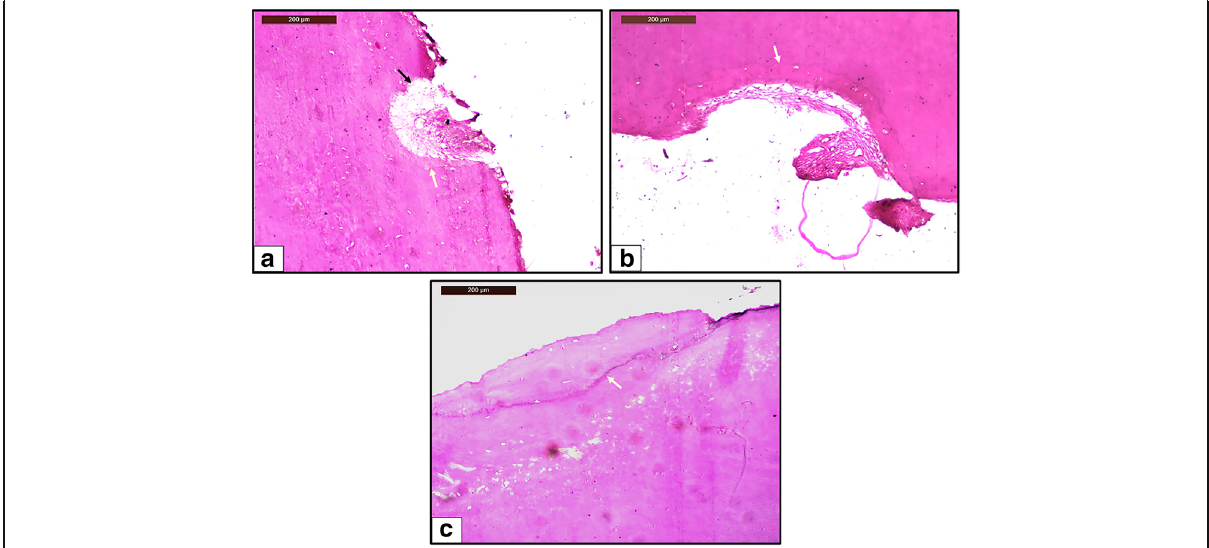
Fig. 7 Light microscope view of different levels of repair. Magnification of ×10. a Partial repair of resorption crater seen in a tooth from group A. Only a part of the surface of the resorption crater is covered with reparative cementum, and the remaining surface is exposed ( black arrow ). b Functional repair of resorption crater seen in a tooth from group A. The entire surface of the resorption crater is covered with reparative cementum without re-establishment of the original root contour. c Anatomic repair of resorption crater seen in a tooth from group B. The entire surface of the resorption crater is covered with reparative cementum to such an extent that the original root contour is re-established. White arrow indicates the reversal line in each